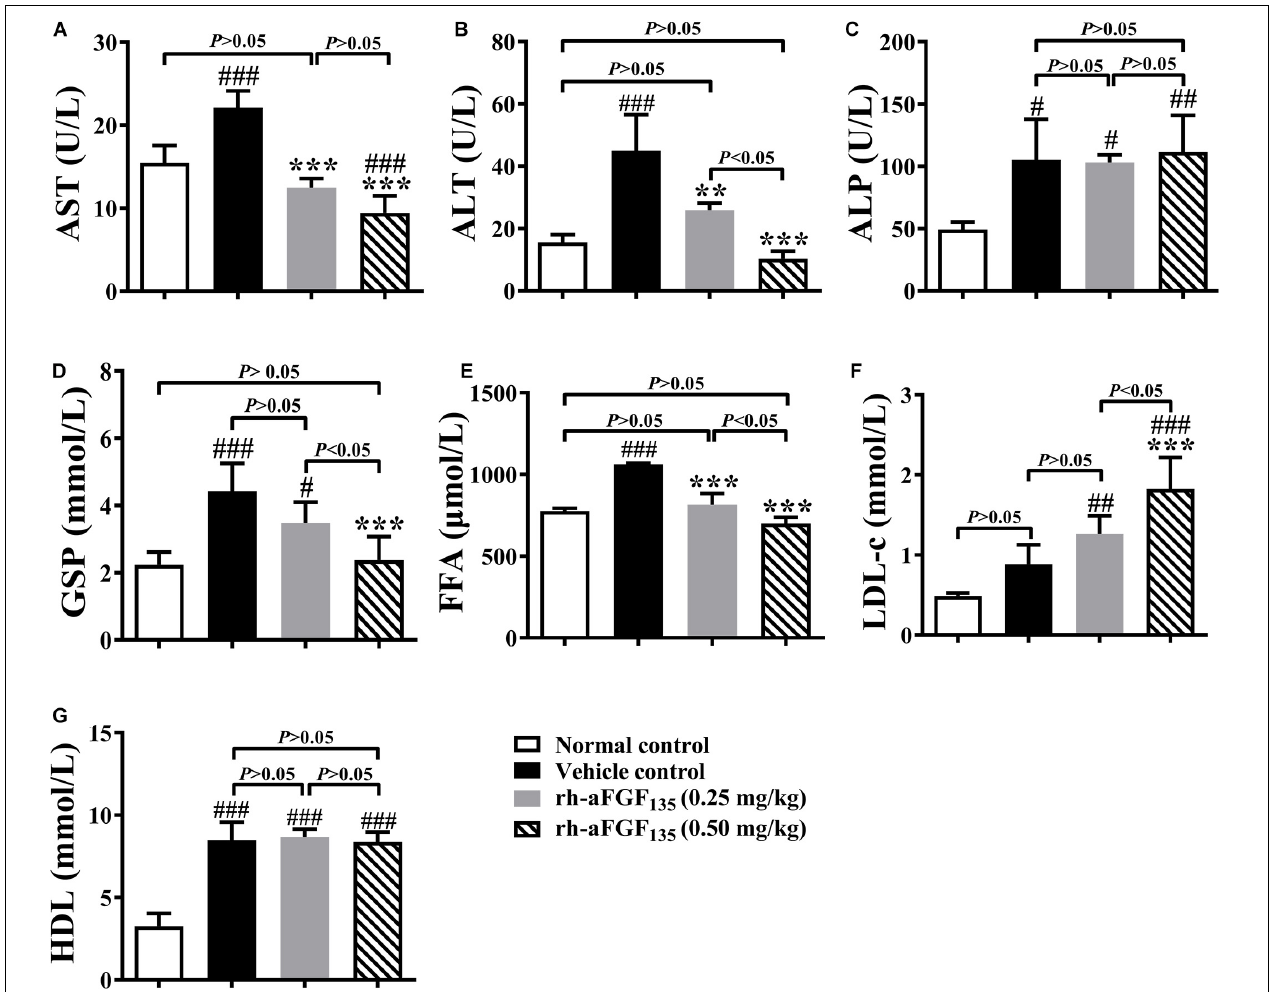
FIGURE 4 | Effects of rh-aFGF 135 on AST (A) , ALT (B) , ALP (C) , GSP (D) , FFA (E) , LDL-c (F) , and HDL (G) levels in the serum of diabetic ZDF rats. Compared to normal control, ### P < 0.001, ## P < 0.01, # P < 0.05; Compared to vehicle control, *** P < 0.001, ** P < 0.01, n =